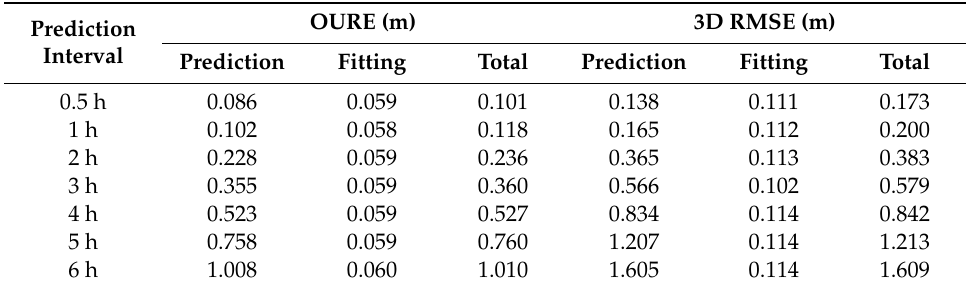
Table 7. The error budget of the Level A products at di ff erent prediction periods.